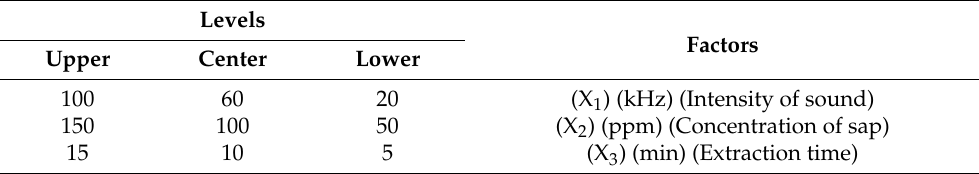
Table 1. Extended values of parameters.